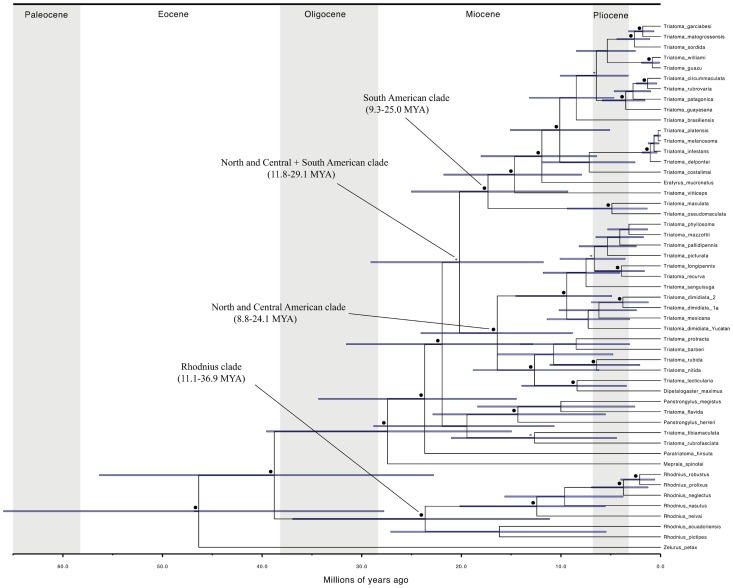
Divergence time estimates for Triatominae clades.Asterisks and black circles above branches indicate clades supported by PP of 0.9–0.94 and ≥0.95, respectively.